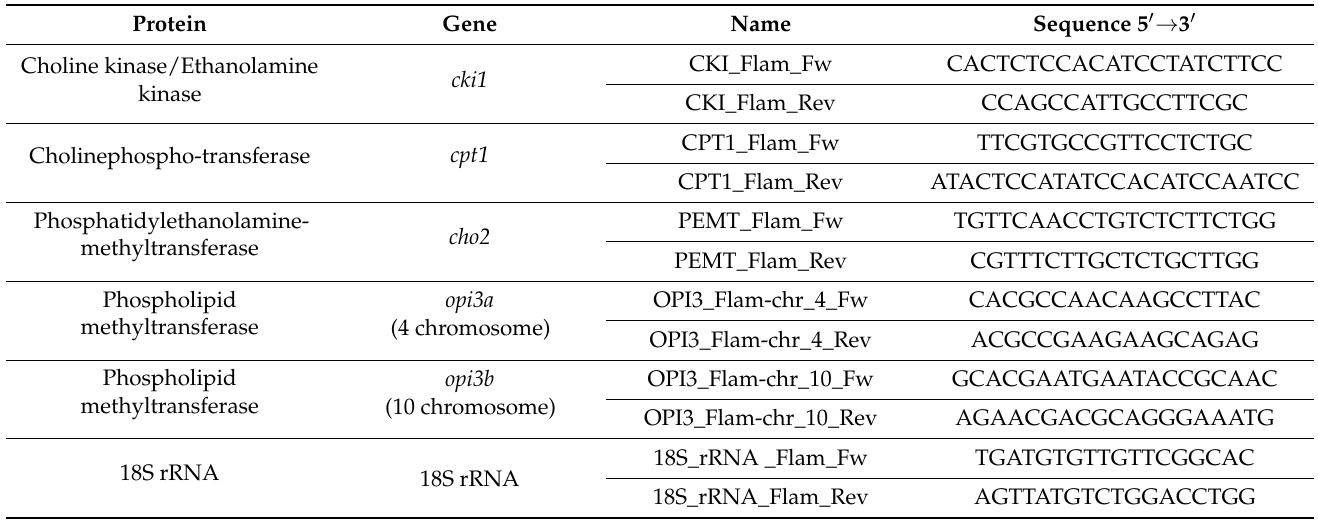
Table 1. Primers used in this